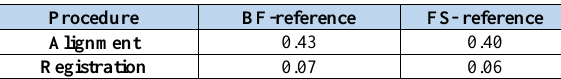
Table 2: Errors (in mm) in alignment and registration procedure